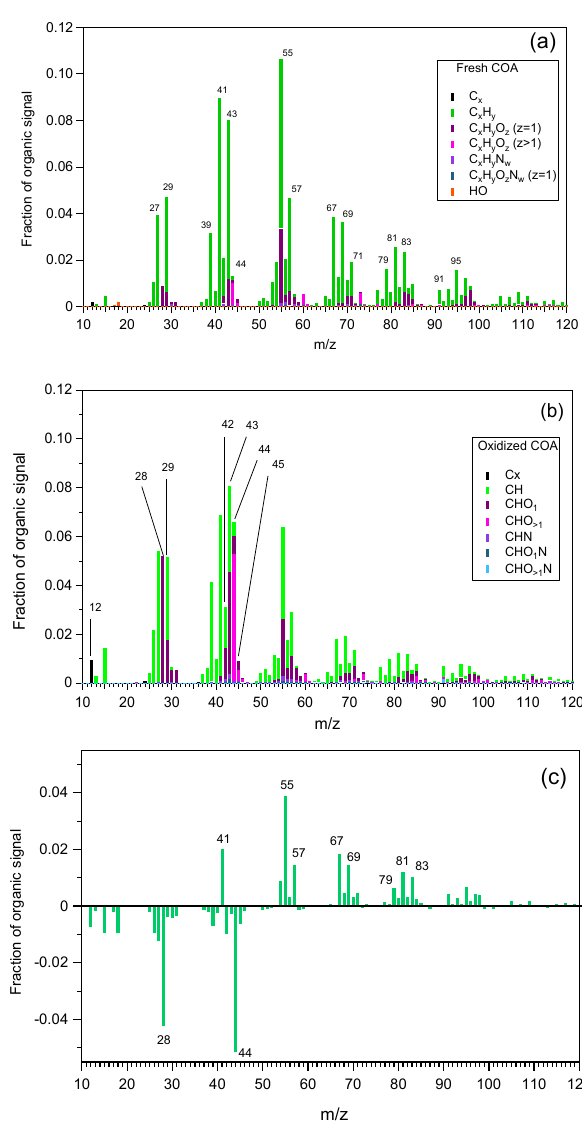
Figure 1. (a) Fresh COA mass spectrum, (b) aged COA mass spec- trum for Experiment 2 (8h of UV), and (c) the difference between the fresh and aged COA.